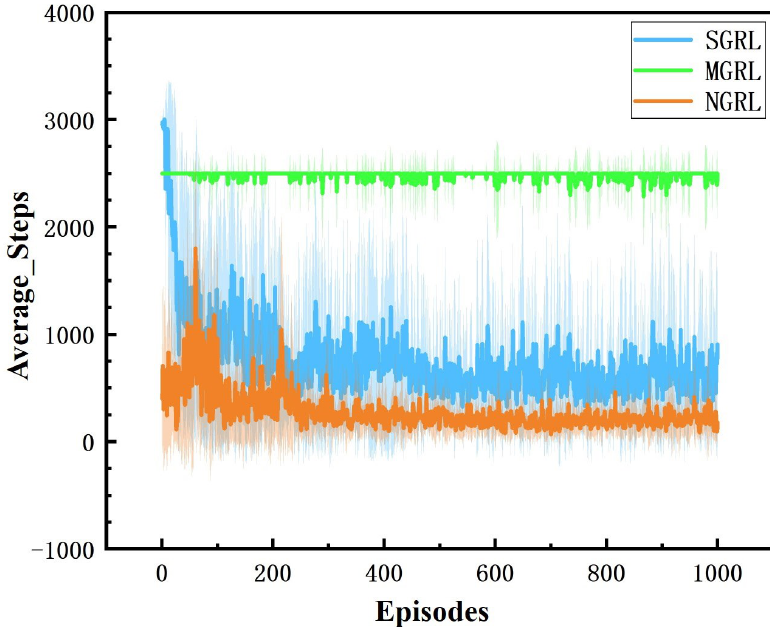
Figure 17. Diagram of average steps. This value is the number of steps experienced at the end of each episode.